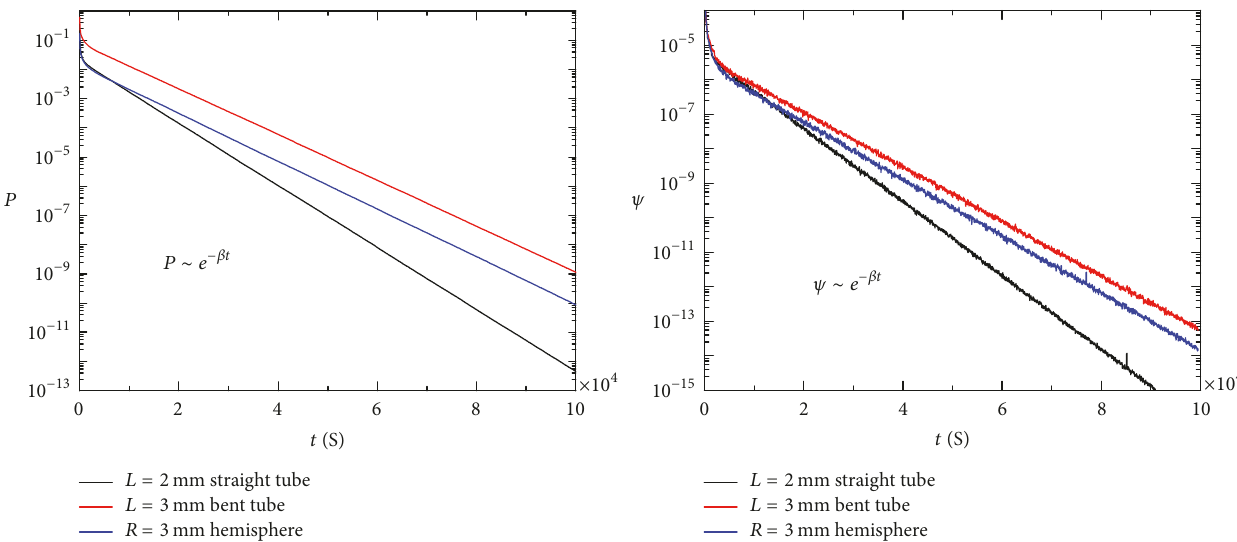
Figure 4: The exponential decrease of 𝑃(𝑡) and Ψ(𝑡) at large time for each type of dead-end